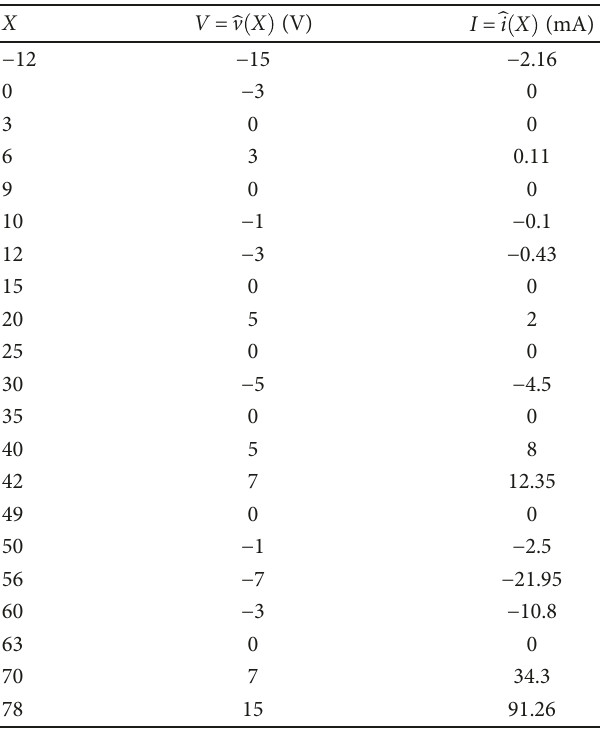
Table 1: Numerical values of the 6-lobe corsage memristor obtained from parametric representation over − 12 ≤ X ≤ 78